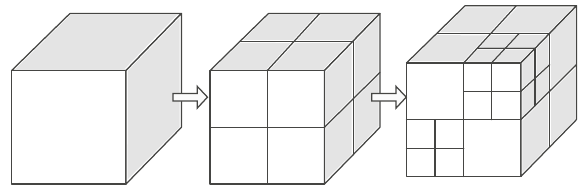
Figure 4: Octree based space partition.